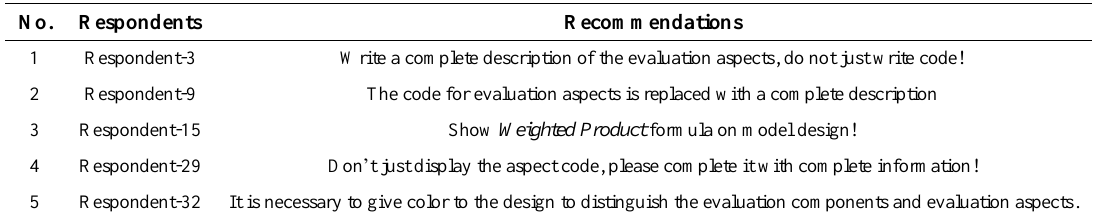
Table 9. Suggestions from Several Respondents on the Design of Formative-Summative Evaluation Models based on Tri Pramana-Weighted Product